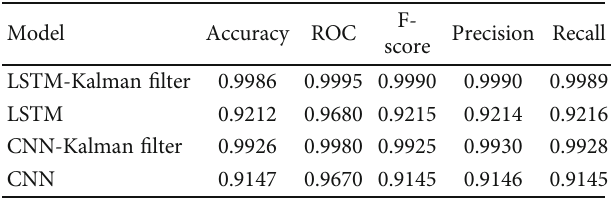
Table 1: Performance of compared methods.